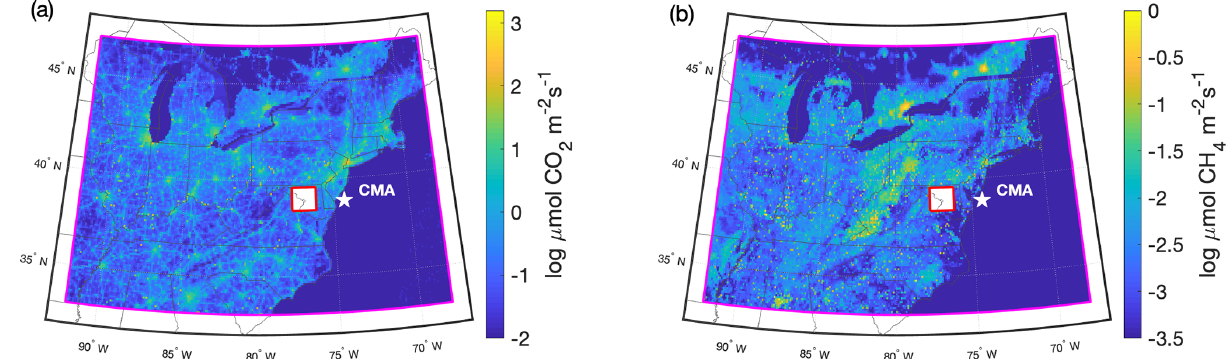
Figure 2. Maps of nested domains used to calculate the two-component background. The outer domain (magenta) is used to determine the near-field background ( y BGnear ) using footprints from STILT and existing flux inventories. (a) January 2015 mean of fossil-fuel CO 2 from Vulcan 3.0 with FFDAS in the Canada portion of the domain is shown in log scale. (b) January 2015 mean of the EPA CH 4 inventory with EDGAR in the Canada portion of the domain is shown in log scale. A global model is sampled at the edge of the outer domain for the far-field background ( y BGfar ). The red square over Washington, DC, and Baltimore, MD, corresponds to the domain shown in Fig. 1. The white star indicates the location of the NOAA aircraft site CMA. All map data layers obtained from U.S. Government sources and in the public